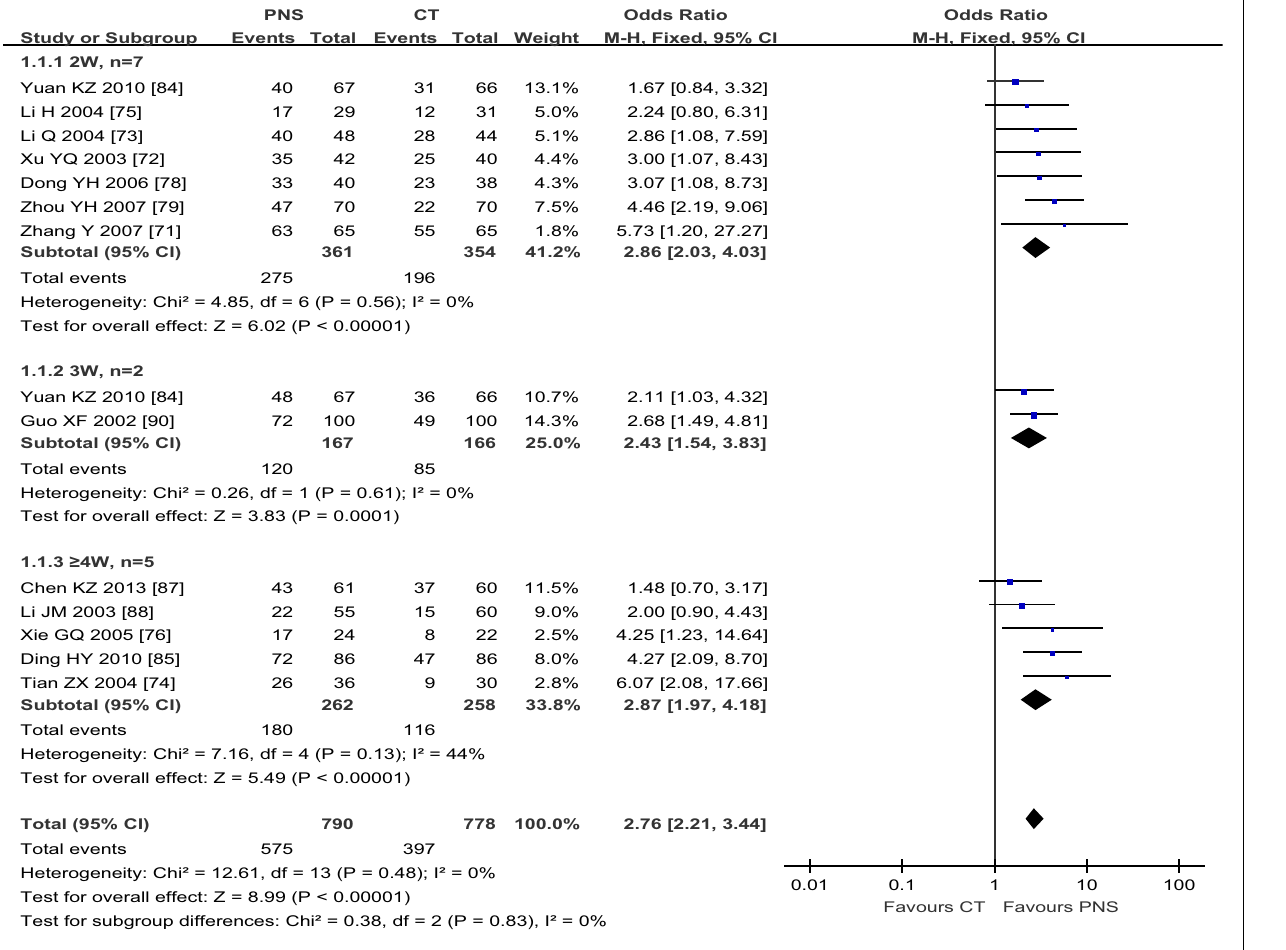
FIGURE 2 | Meta-analyses of the effectiveness rate (ER), comparing the therapeutic effects of PNS injection with that of the current treatment (CT) .There is an overall significant statistical difference in ER between the